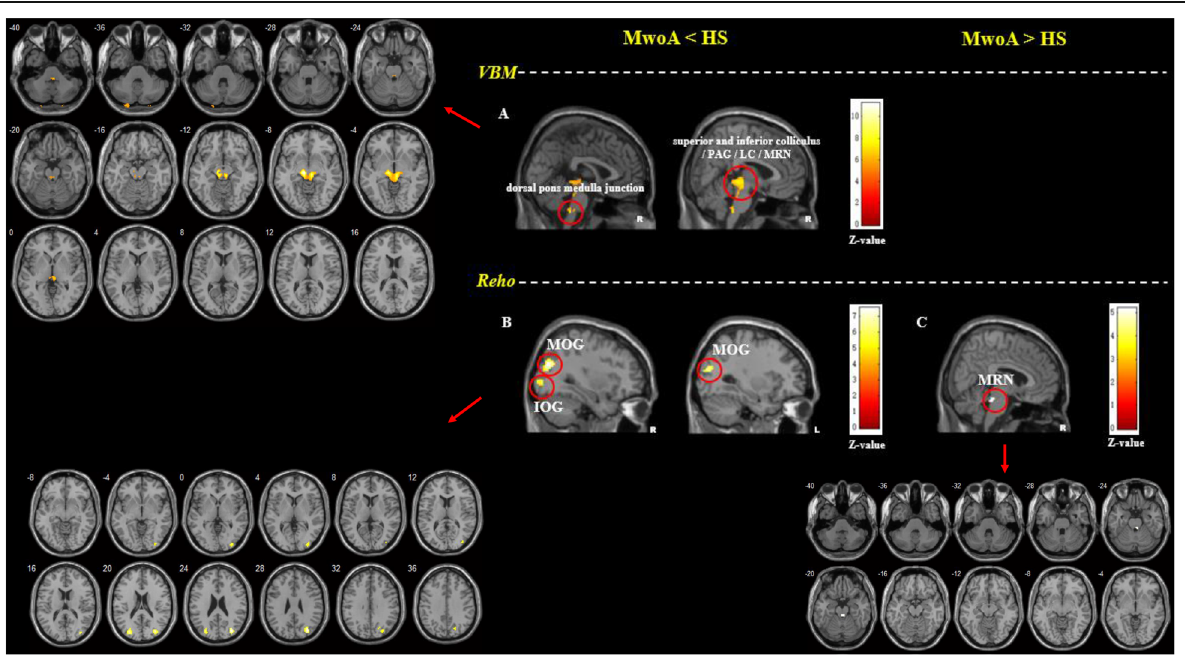
MwoA > HS 11 bilateral MRN